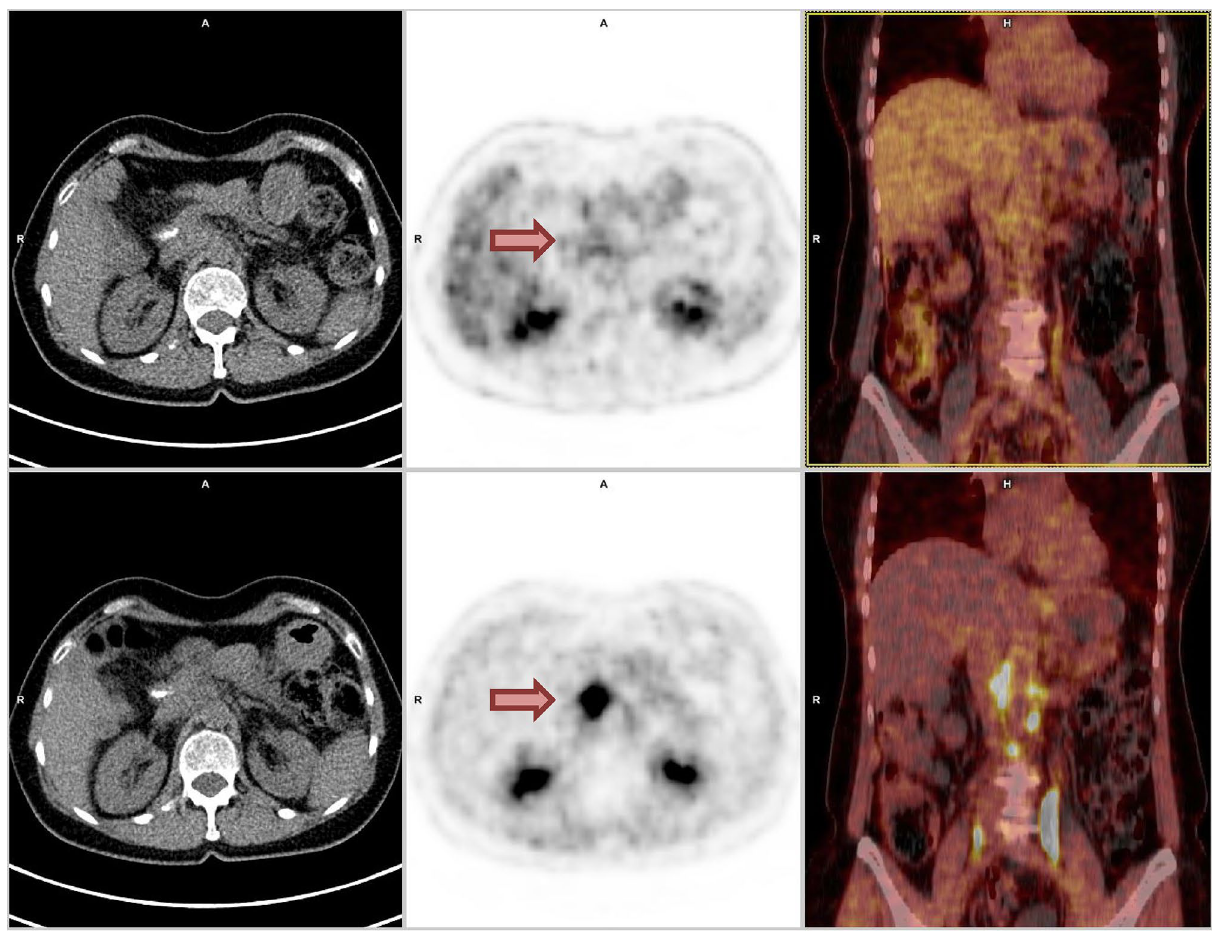
Figure 4. Showing patient H with a lymphonodular metastatic pancreatic ductal adenocarcinoma at timepoint t 1 . Upper and lower left-side: unenhanced CT; upper middle column: [ 18 F]FDG-PET; lower middle column: [ 68 Ga]FAPI-PET (both axial reconstructions at the level of the kidneys); upper and lower right-side: fused mode [ 18 F]FDG-PET/CT (upper row) and [ 68 Ga]FAPI-PET/CT (lower row) displaying assessment of index lesions (red arrows) [point-spread function (PSF) reconstruction; PET Heat 2D, 55 min after 101 MBq [ 18 F]FDG injection and 27 min after 106 MBq [ 68 Ga]FAPI-injection]. Uptake on [ 18 F]FDG-PET-images [ 18 F]FDG-uptake was minimal and only slightly elevated compared to background